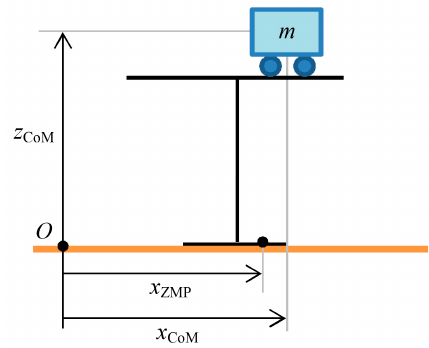
Figure 5. The cart-table model with the cart representing the center of mass (CoM) of the biped robot, and the foot of the table representing the stance foot of the robot.